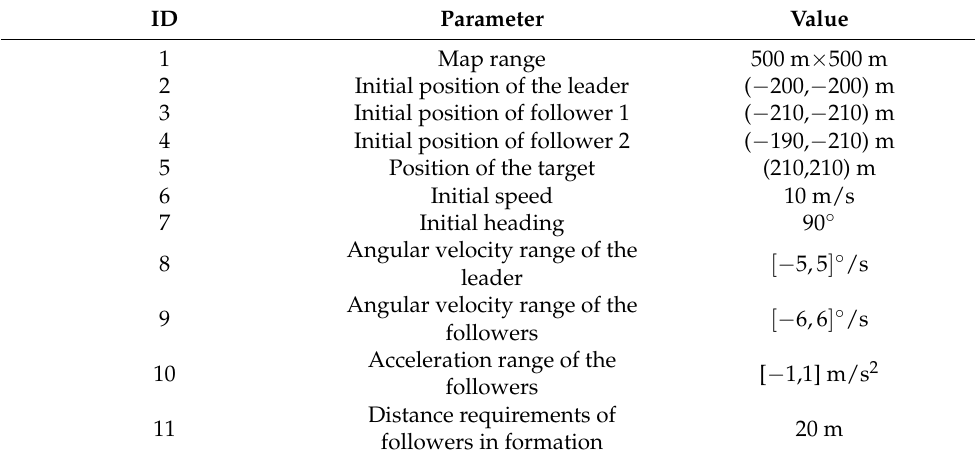
Table 2. List of Parameters Used in DDPG Algorithm.